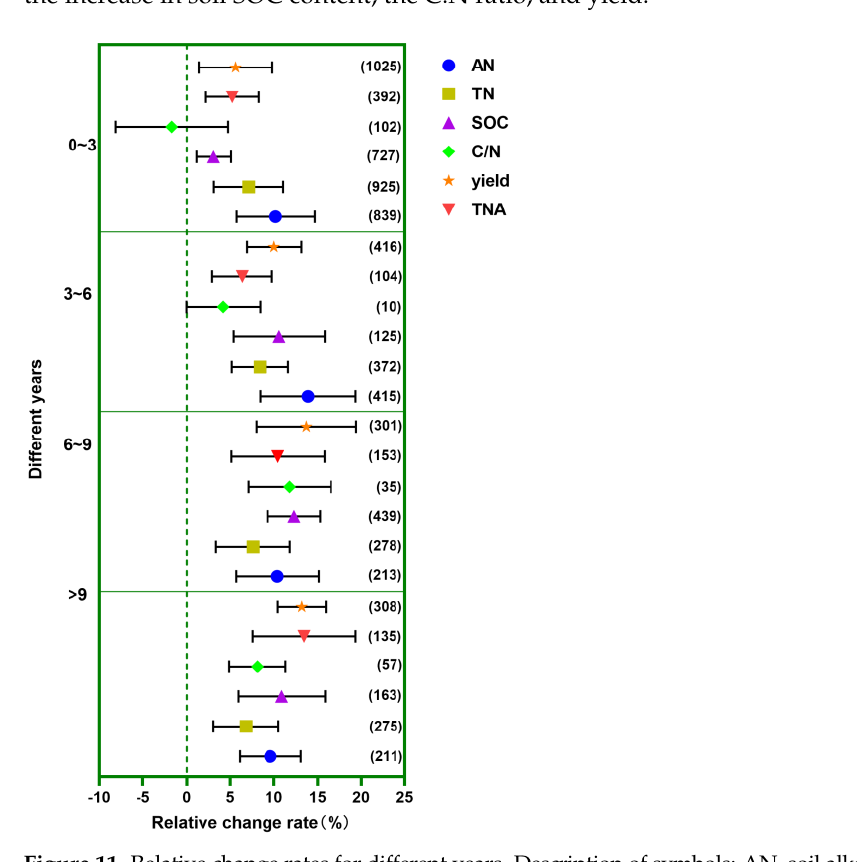
Figure 11. Relative change rates for different years. Description of symbols: AN, soil alkali-hydrolysable nitrogen; TN, soil total nitrogen; SOC, soil organic matter; C:N, soil carbon-nitrogen ratio. Numbers in parentheses represent the effect value (lnR).